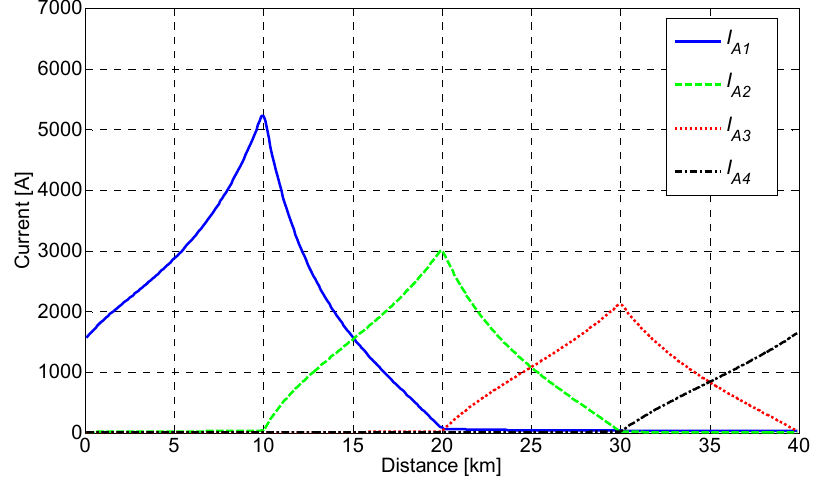
Figure 10. Currents in autotransformers as a function of the distance from the traction substation when a ground fault occurs between the catenary and rail along different zones in a section with four subsections.